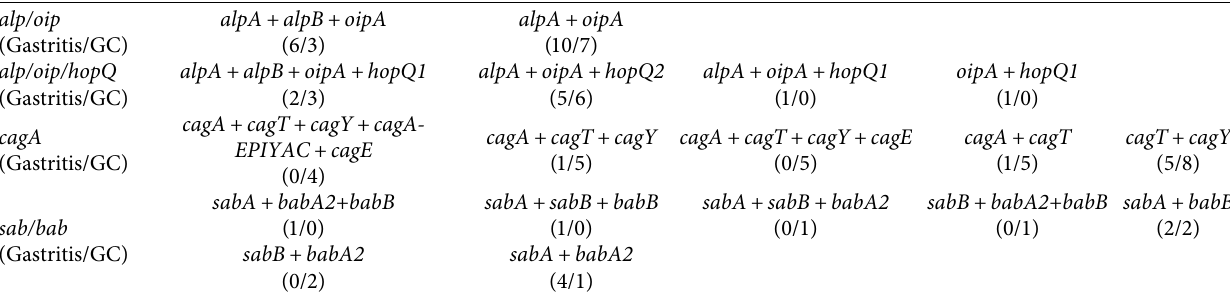
Table 7: The combined cDNA detected in gastric antral biopsy samples. Some samples had single cDNA that we did not mention. These findings were collected of 23 and 11 gastric antral biopsies in gastritis and gastric cancer samples with H. pylori infection, respectively. There